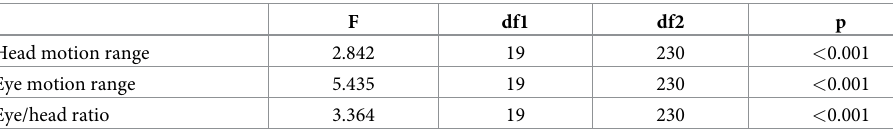
Table 1. Test for equality of variances (Levene’s test) in %